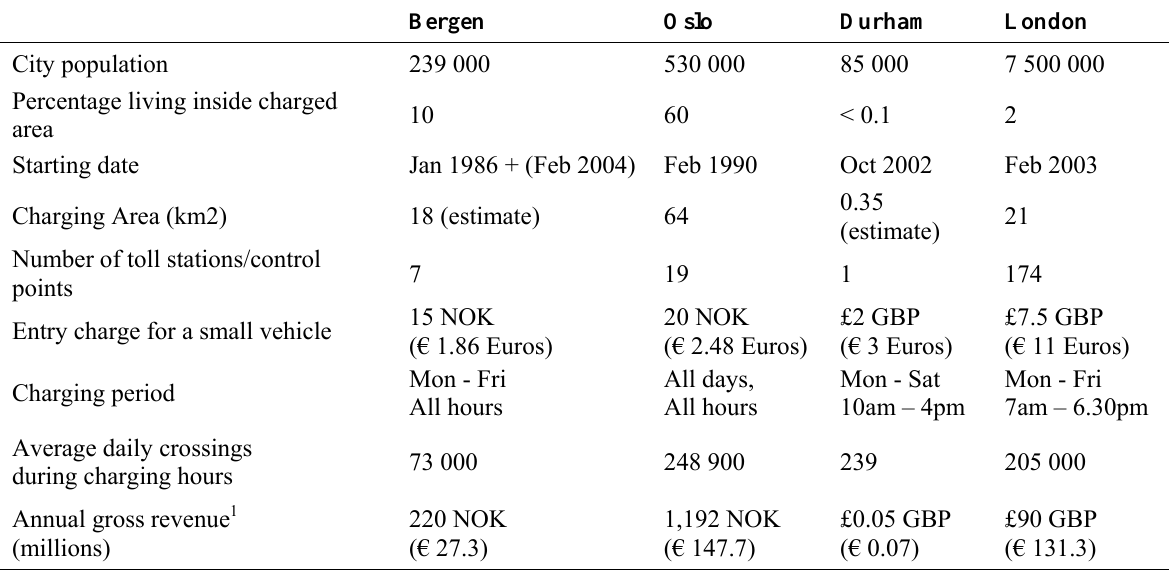
Table 1. Selected characteristics of the four cities under investigation Bergen